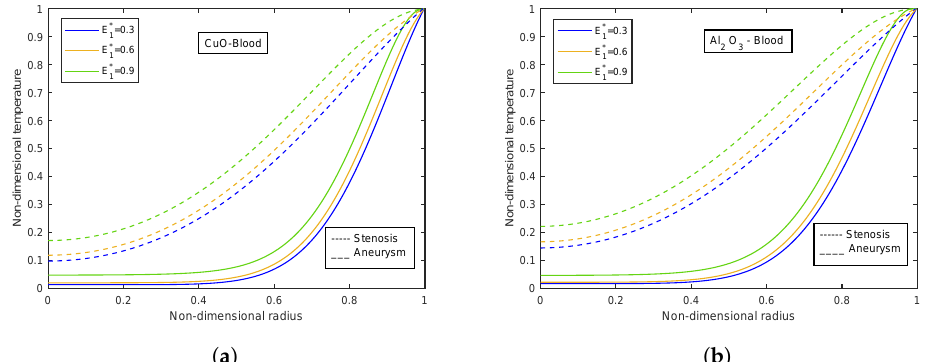
Figure 13. Temperature profiles of electric field parameter E ∗ nanoparticles.